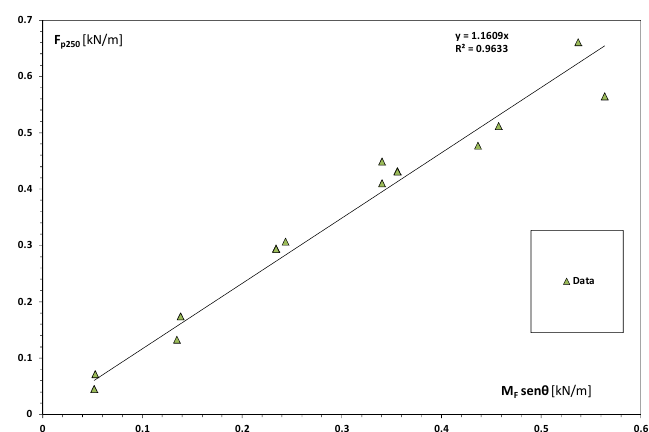
vs. (cid:1839) sin(cid:2036) . P 250 (cid:3007),(cid:2870)(cid:2873)(cid:2868)